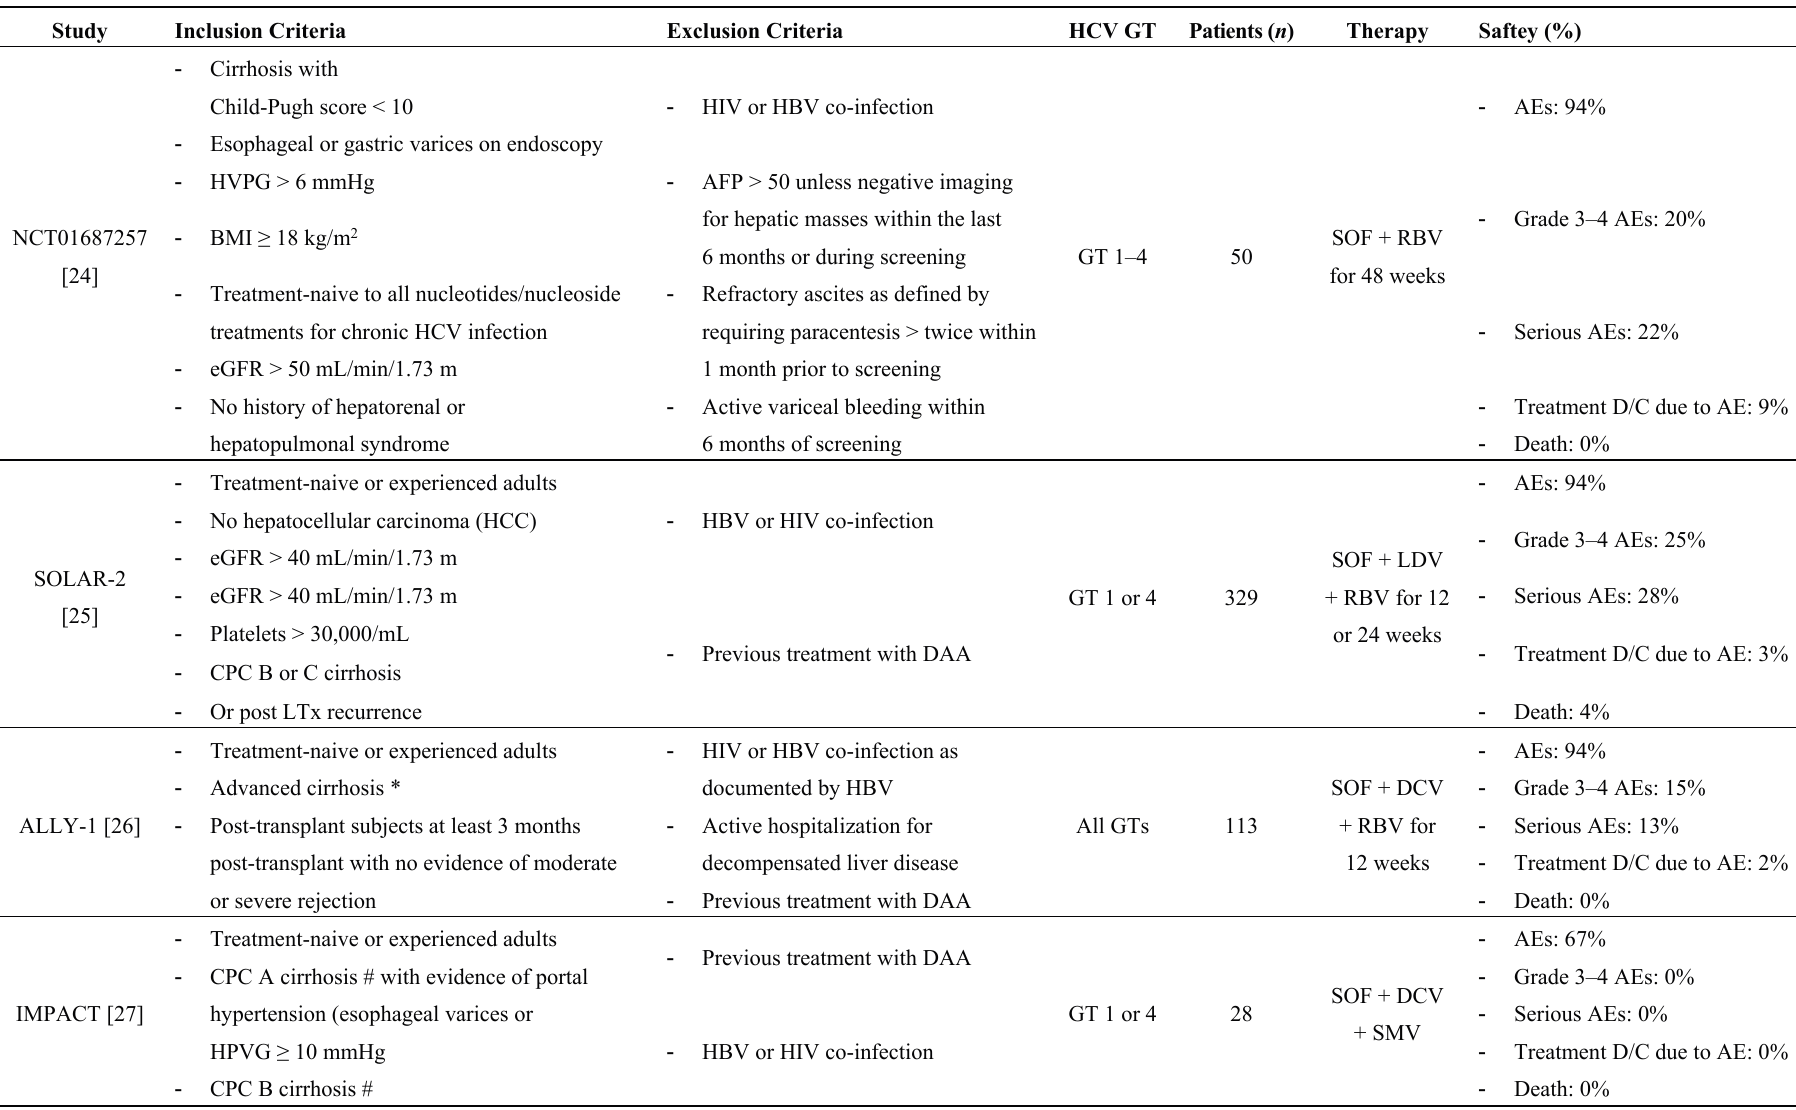
Table 4. Inclusion and exclusion criteria of revised clinical studies in patients with decompensated liver cirrhosis or post liver transplantation.